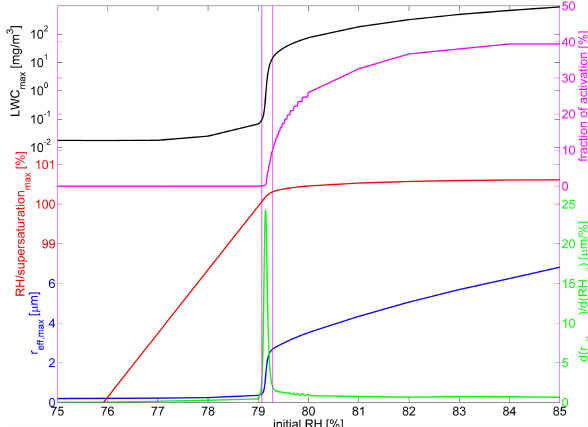
Figure 4. The maximal r eff (blue), maximal RH (red), maximal LWC (black), and fraction of activation (in terms of number size distribution, magenta) of the forming clouds vs. the initial RH of the parcel. The green line is the derivative of the maximal r eff with respect to the initial RH of the parcel. Transition-zone clouds are defined within the vertical magenta lines (see text for further expla-